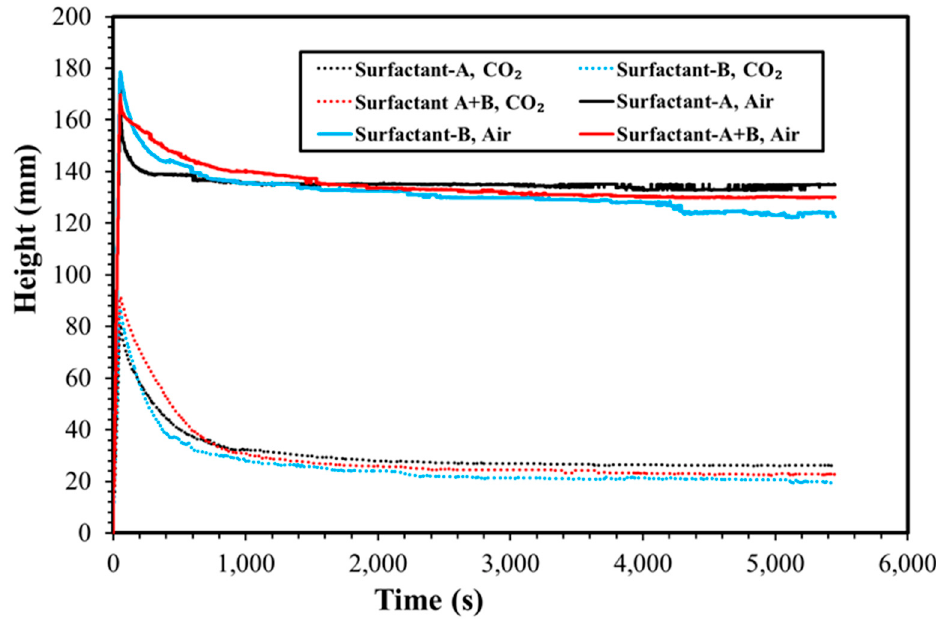
Figure 2. Foam height vs. time for different surfactant system using air and CO 2 at 25 °C.